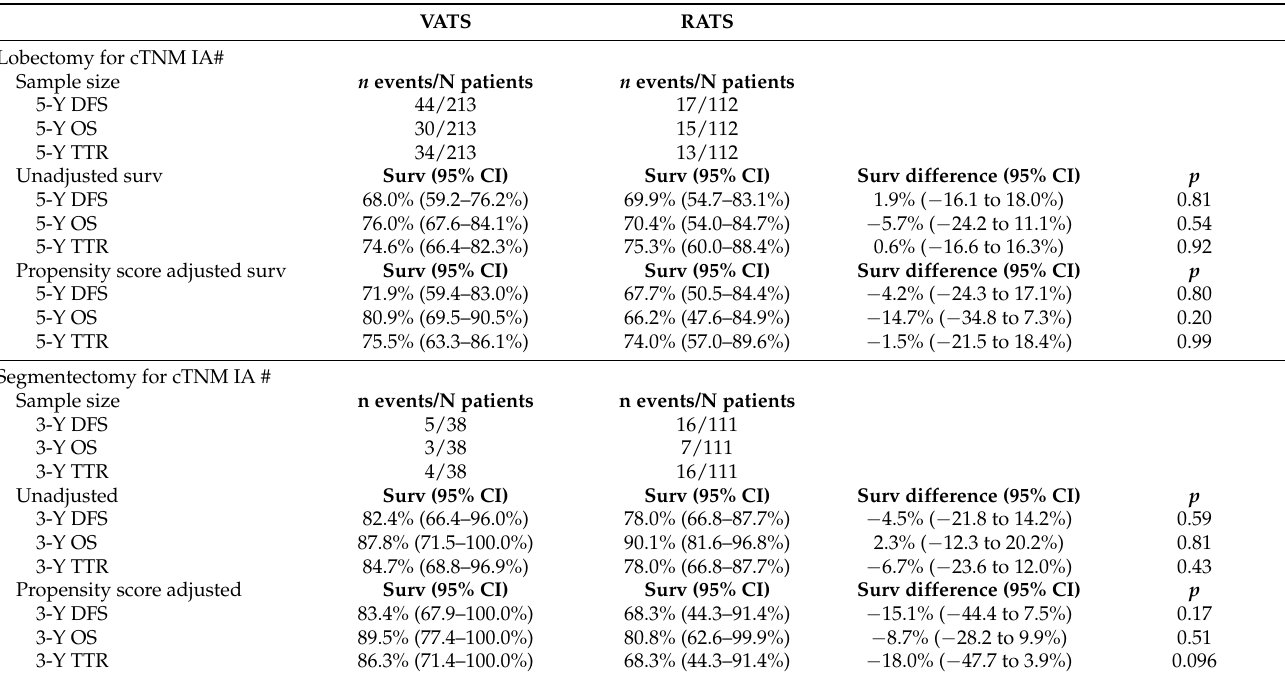
Table 5. Unadjusted and adjusted comparison of long-term survival in the subgroup of patients with cTNM stage I tumors.